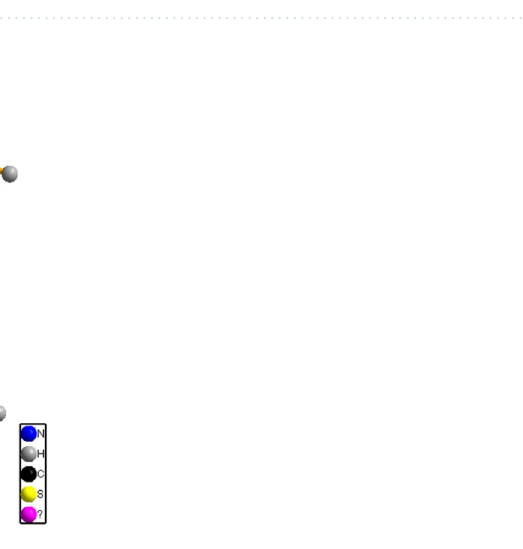
Figure 4. Hydrogen bonds ring ( a ) {[Co(SCN) 4 ] (C 8 H 12 N) 3 }·Cl and ( b ) {[Co(SCN) 4 ] (C 5 H 11 N 3 ) 3 }·2Cl.